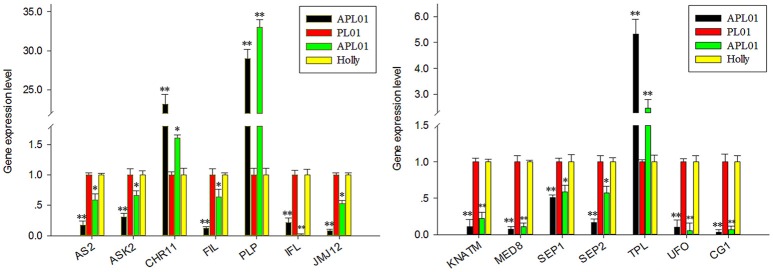
Verification of TG expression patterns by using qRT-PCR. Fourteen putative petal regulators showed the same expression patterns between “APL01” and “PL01” (black and red bars, respectively) as between “APL01” and “Holly” (green and yellow bars, respectively). Rapeseed ACTIN was chosen as the internal control to normalize the expression data. Data are the mean with standard error (SE) from three independent experiments. Single asterisk indicates that the difference is significant (non-paired t-test, P < 0.05), double asterisks indicate that the difference is extremely significant (non-paired t-test, P < 0.01).